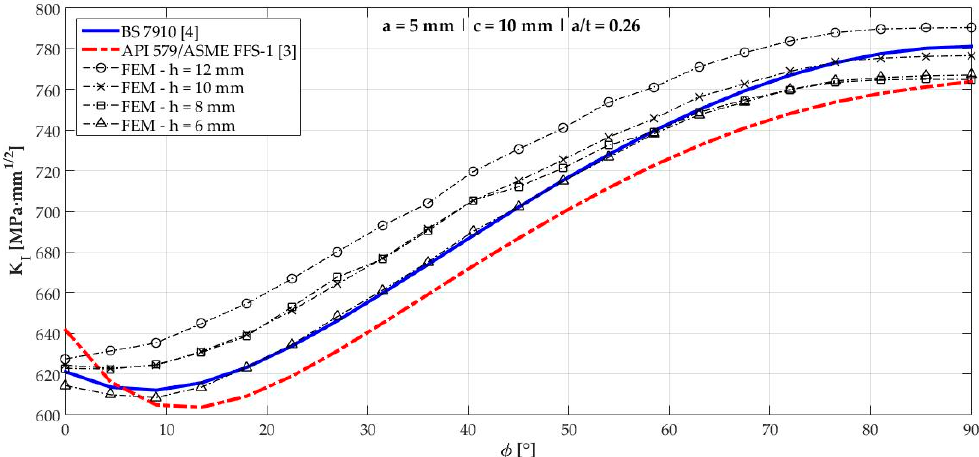
Figure 6. Mode I Stress intensity factor (SIF) profiles for crack 1 ( a = 5 mm , c = 10 mm , and a/t = 0.26 ).